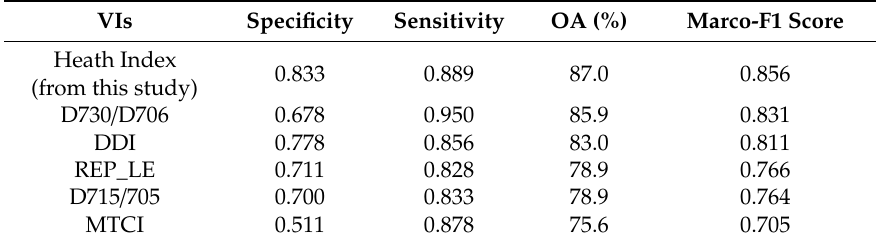
Table 4. Validation results of di ff erent SCR detection models using support vector machine-based 10-fold cross